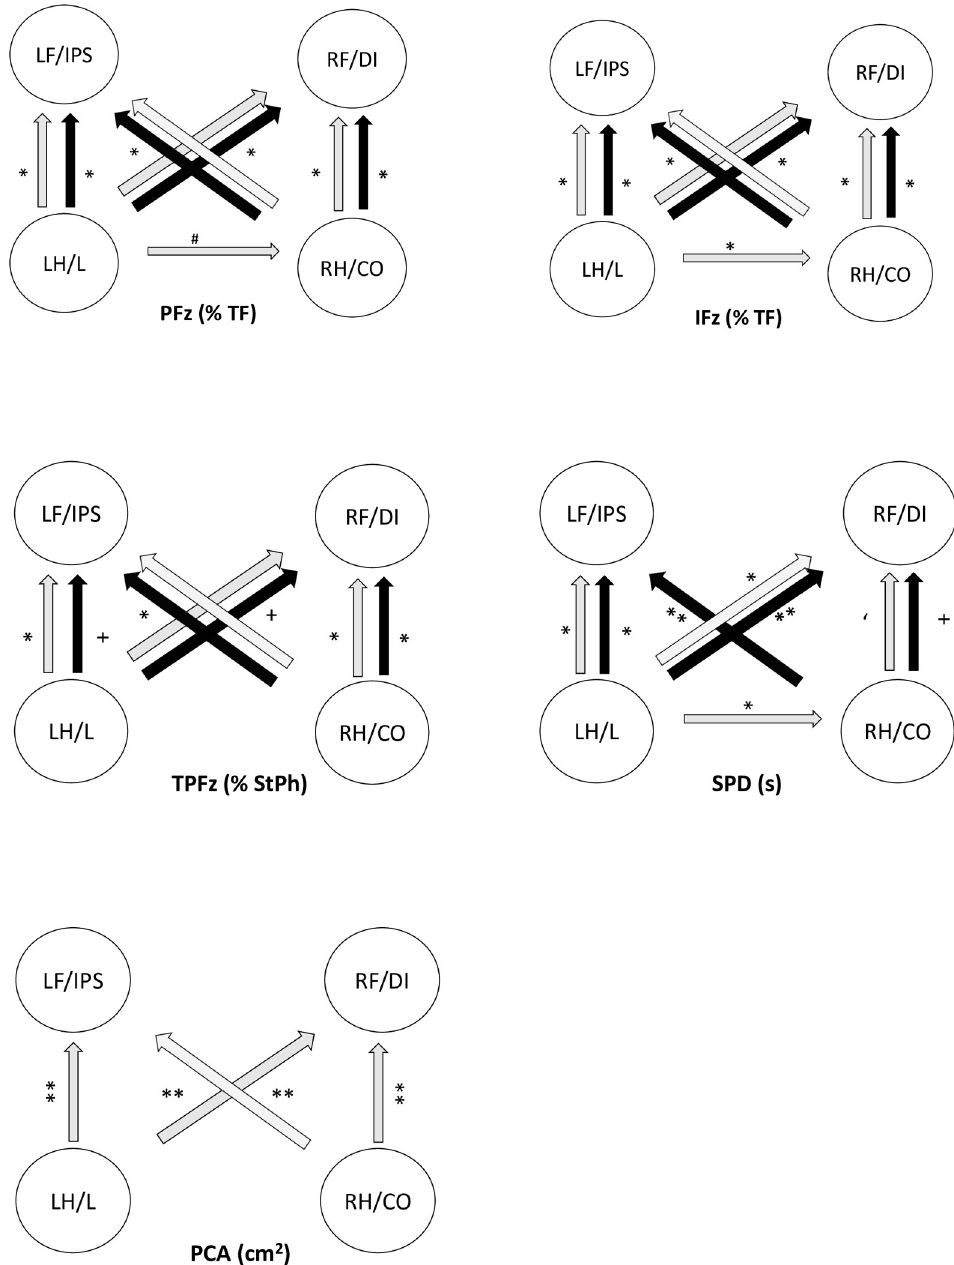
Fig 1. Statistically significant differences in the limbs between the LC and NLC groups. The arrows are pointing towards the higher values. The grey shaded arrows indicate the LC and the black arrows indicate the NLC. � p = 0.000, �� p = 0.001, ‘p = 0.002, + p = 0.003, # p = 0.036, CO = contralateral, DI = diagonal, IFz = vertical impulse, IPS = ipsilateral, L = lame, LC = lame cats, NLC = sound cats, PCA = paw contact area, PFz = peak vertical force, SL = step length, SPD = stance phase duration, StPh = stance phase, TF = total force, TPFz = time to PFz. However, in the LC group, the step length was significantly shorter for all four limbs when the stifle joint was affected (lame limb, p = 0.038; contralateral limb, p = 0.036; ipsilateral limb, p = 0.041; diagonal limb, p = 0.005) than after FHO.